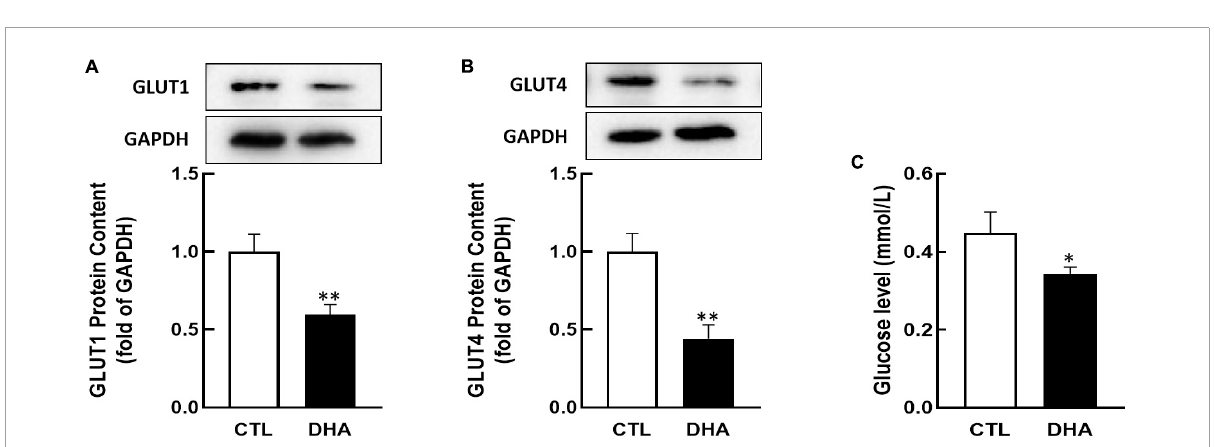
FIGURE2 Effect of Omega-3 on GLUT1/4 expression and glucose uptake in KGN cells. KGN cells were cultured with omega-3 (25 µ M) for 24 h. The proteins level of GLUT1 (A) and GLUT4 (B) were assessed by Western blot analysis. And the cellular glucose uptake (C) was assessed by 2-DG measurement. Data are presented as mean ± SEM of three independent experiments. ∗ P < 0.05, ∗∗ P < 0.01 compared with